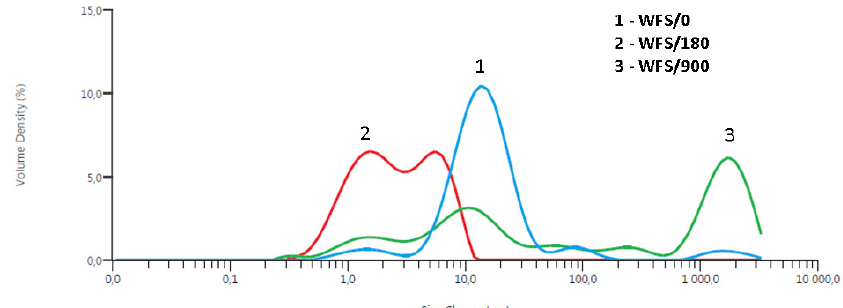
Figure 6. Grain size distribution of pigment waste Fe sludge: 1) original (WFS/0); 2) calcined at 180 °C (WFS/180); 3) calcined at 900 °C (WFS/900).